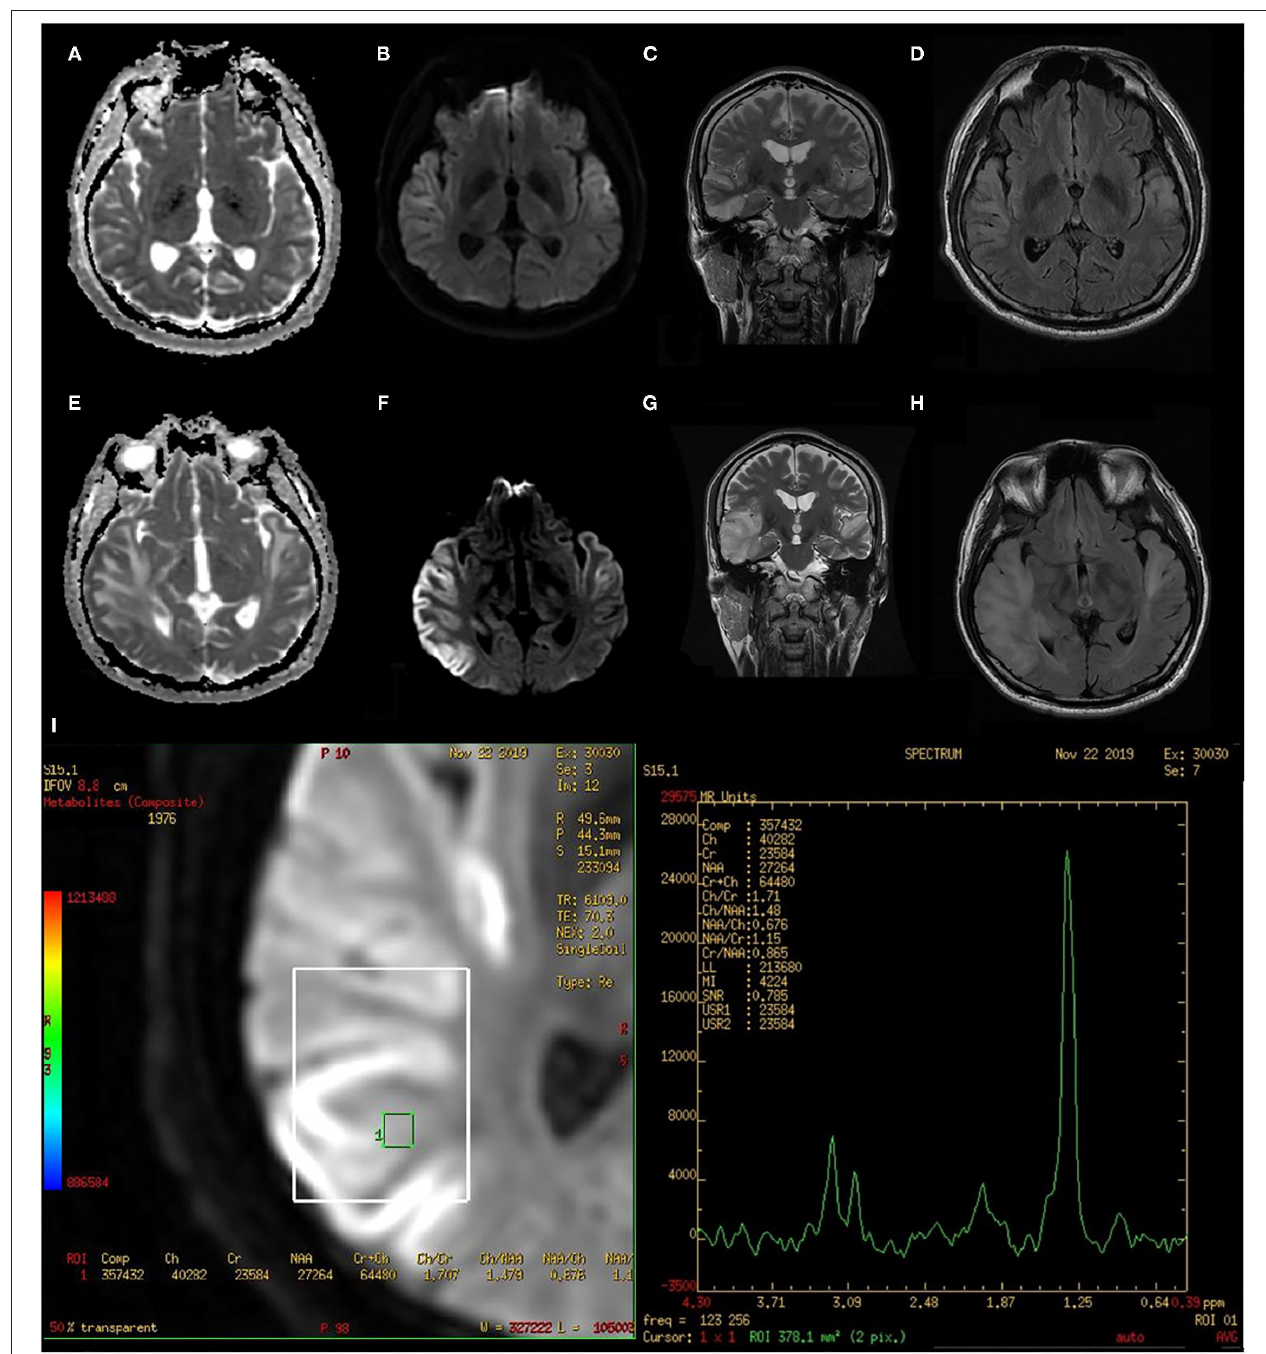
FIGURE 1 | Initial and follow-up MRI after 14 days of acyclovir treatment. (A) initial ADC, (B) initial DWI, (C) initial T2 corona, (D) initial T2 FLAIR, (E) follow-up ADC, (F) follow-up DWI, (G) follow-up T2 corona, (H) follow-up T2 FLAIR, and (I) follow-up MRS. ADC, Apparent diffusion coefficient; DWI, Diffusion-weighted image; FLAIR, Fluid attenuated inversion recovery; MRS, Magnetic resonance